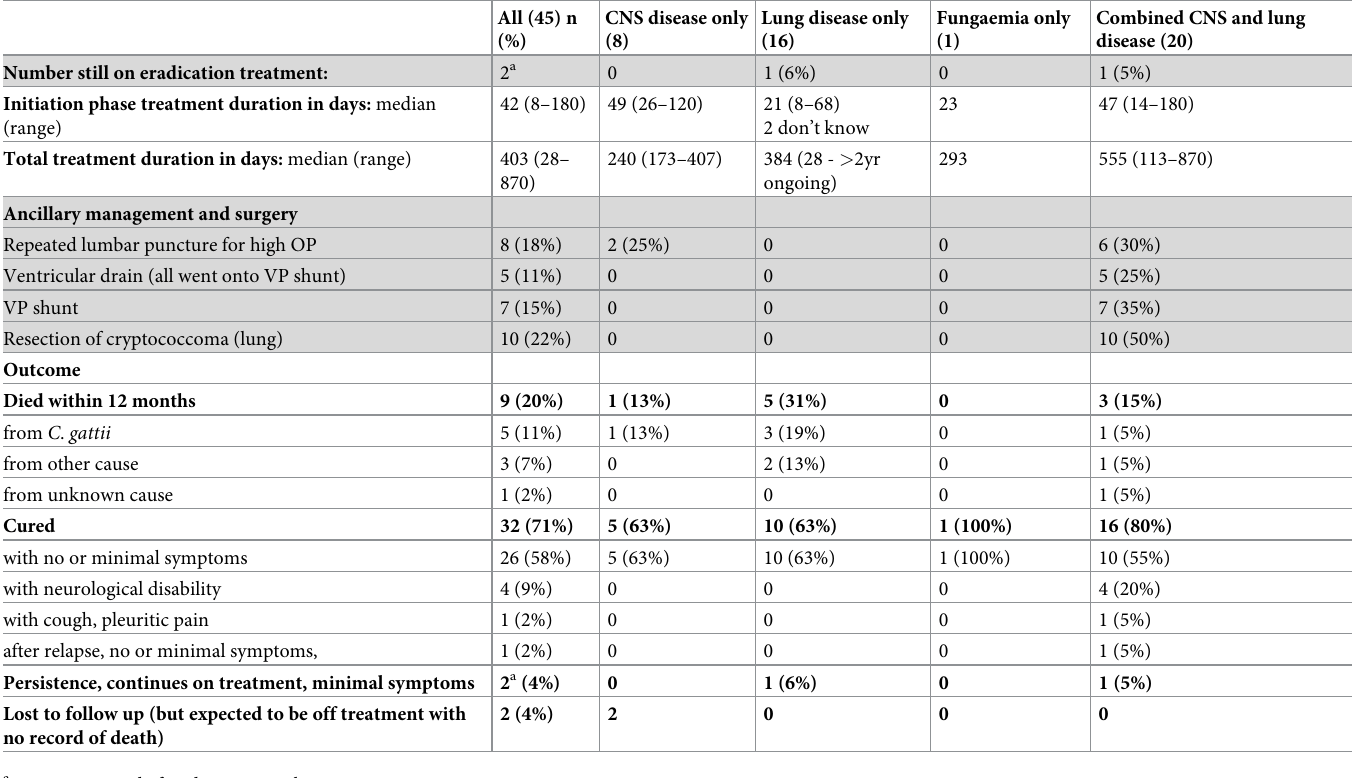
Table 4. Treatment and